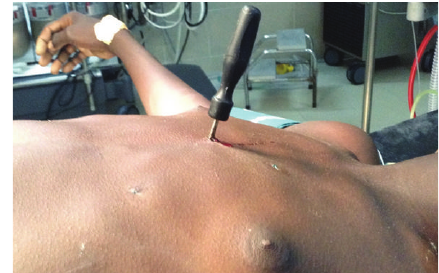
Figure 1: Screwdriver penetrating the chest.